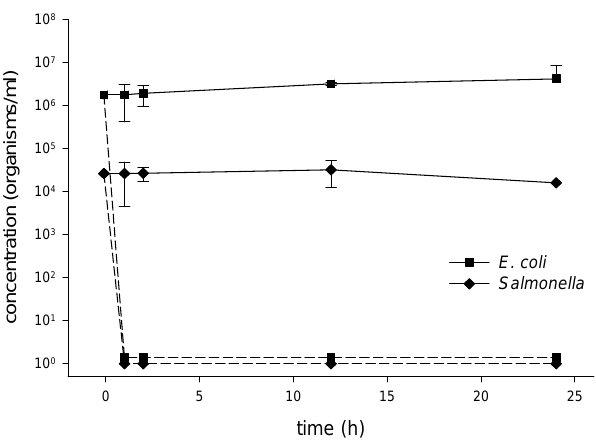
Figure 1: E. coli and Salmonella inactivation by liming stabilization. Results are from three replicate experiments at 28 C. Following a 0.1 h period of liming E. coli counts were reduced by 6 logs and Salmonella sp. was below detectable levels, demonstrating at least a 4-log reduction. Bacterial concentrations of 10 0 were artificially separated for clarity. Means and standard deviations are shown. Continuous lines represent untreated controls, dashed lines treatments.